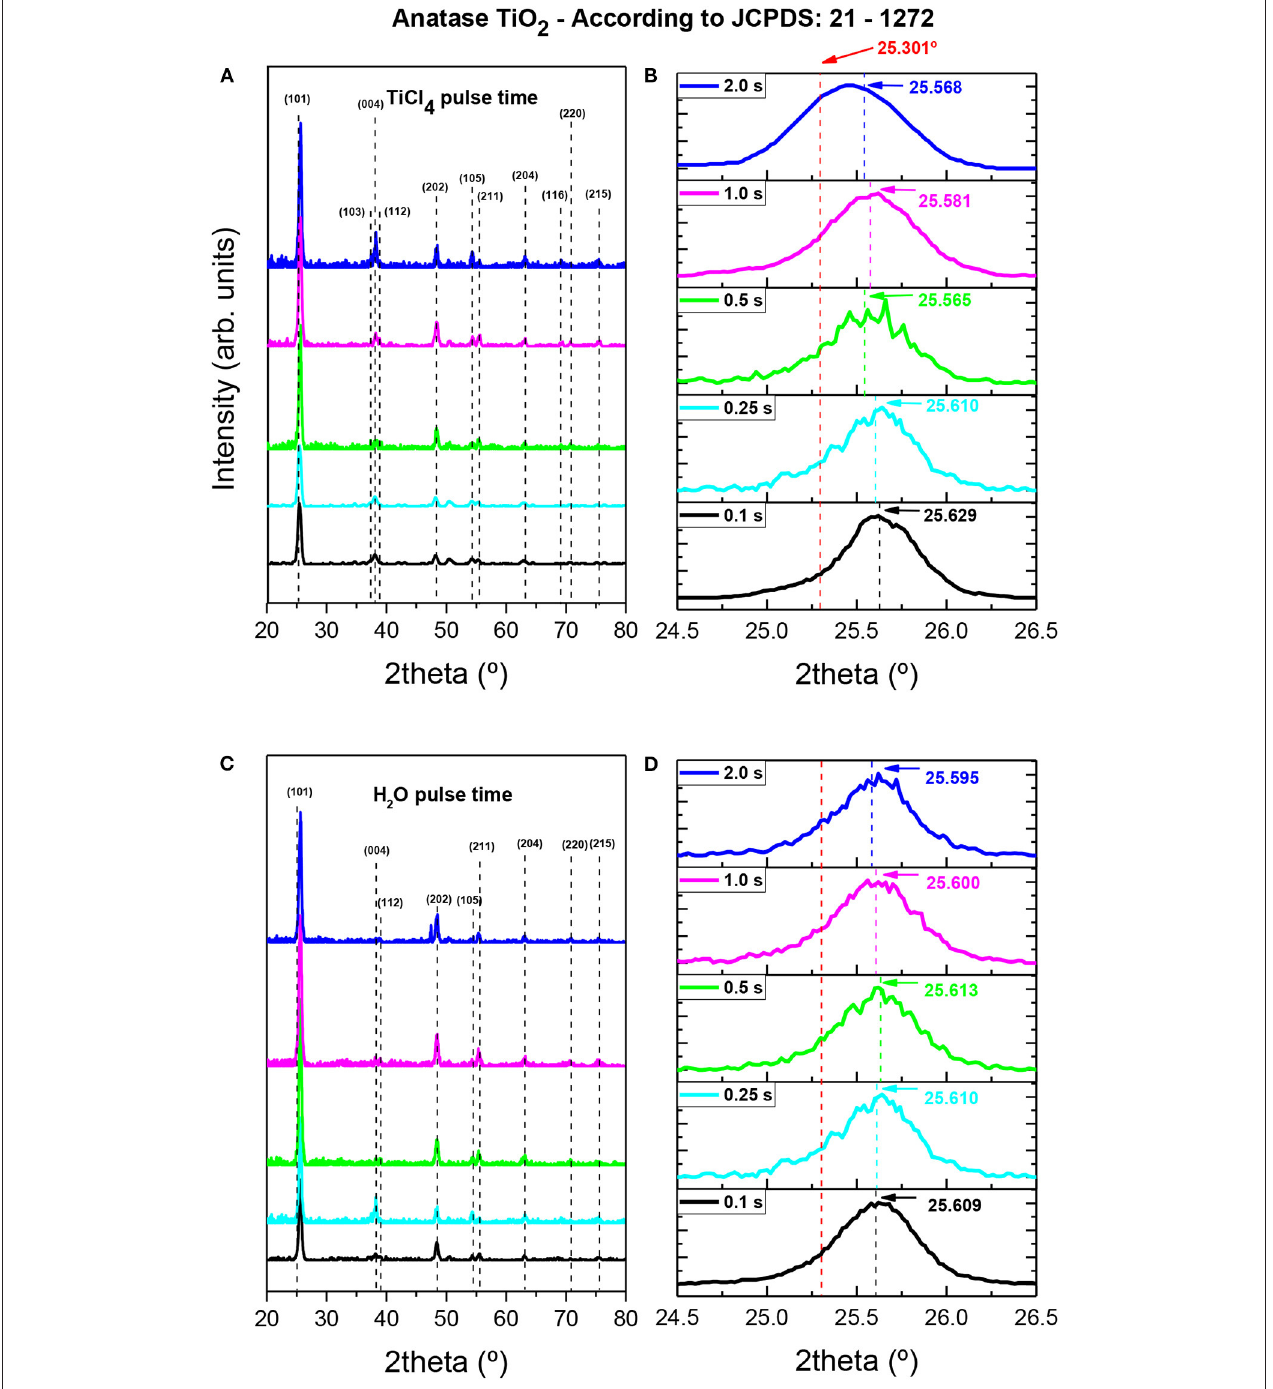
FIGURE 7 | GIXRD diffractogram for TiO 2 film growth using TiCl 4 precursor: (A) first set of samples, (B) peak (101) for the first set of samples, (C) second set of samples, and (D) peak (101) for the second set of samples.